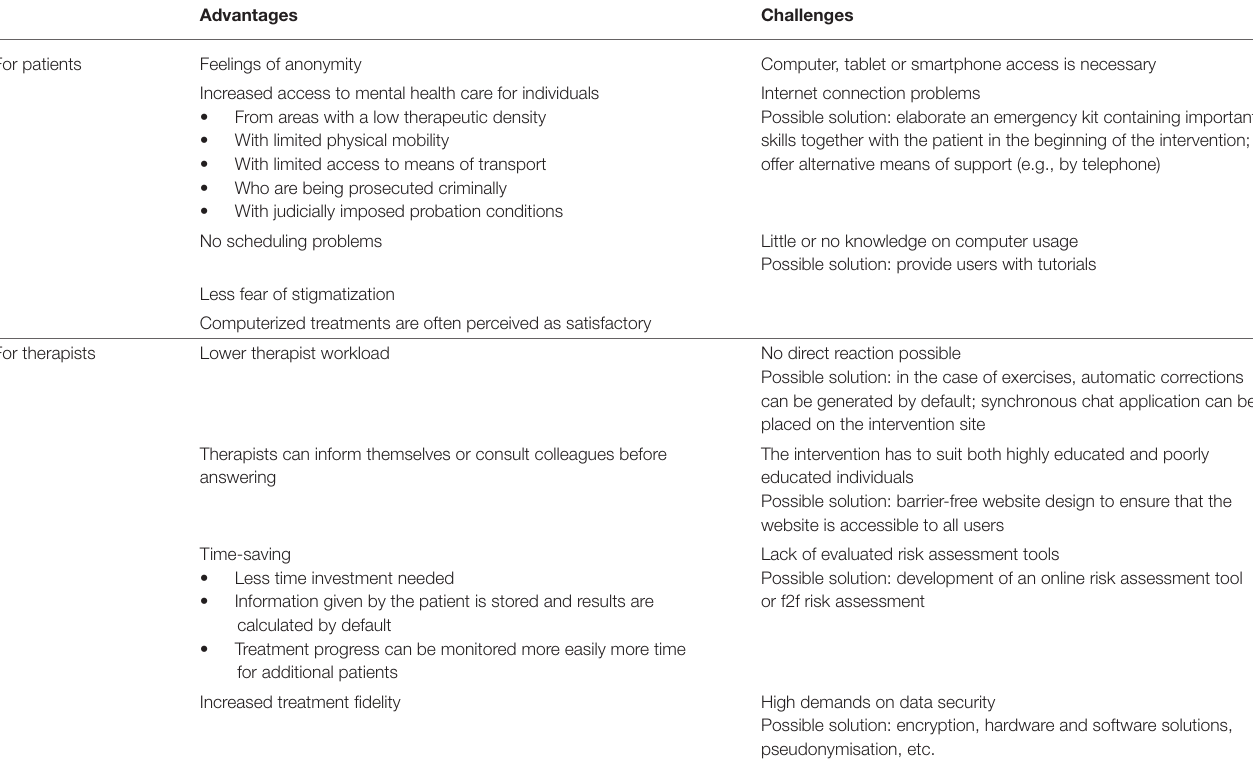
TABLE 2 | Advantages of and challenges in guided web-based interventions for child sexual abusers and child sexual exploitation material